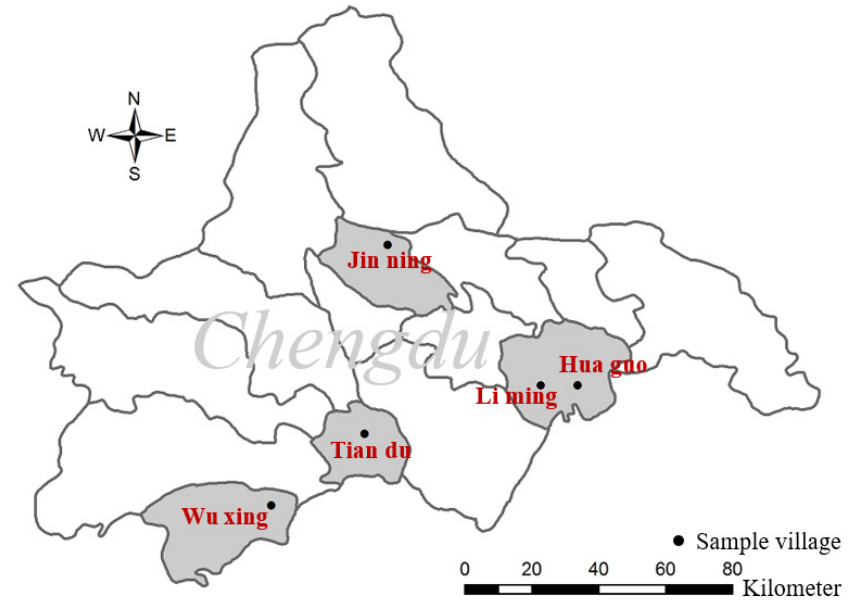
Figure 4. Location of the sample villages. Table 1. Questionnaire survey sampling.